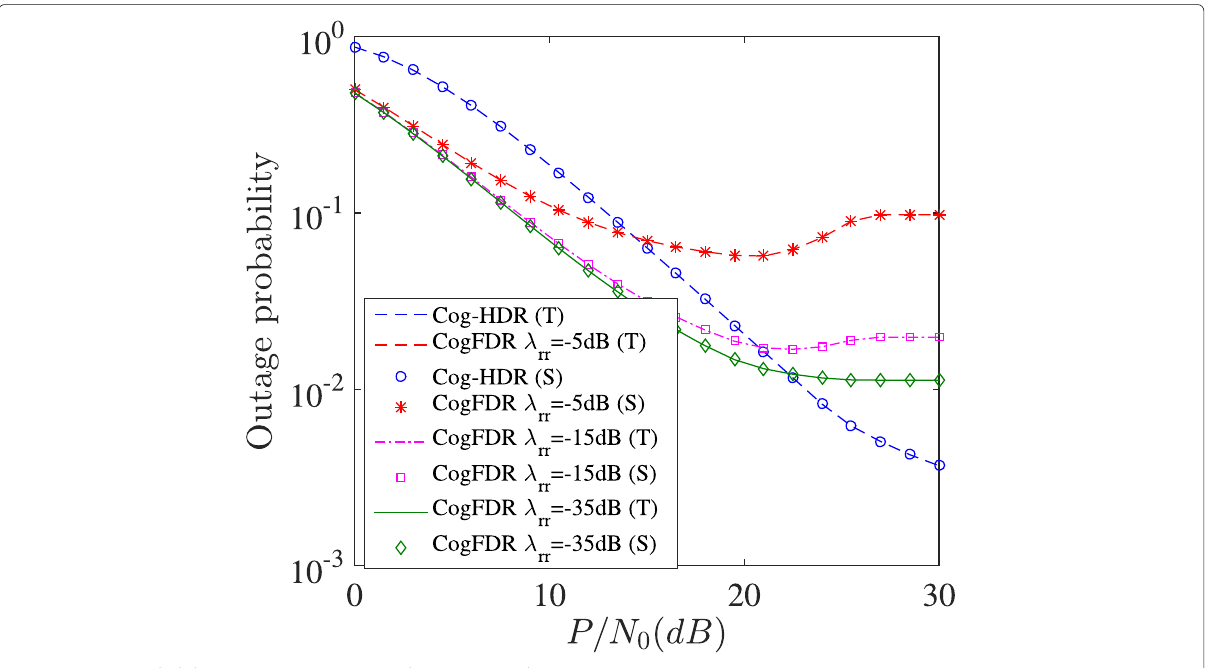
Fig. 3 Outage probability vs. P / N 0 ; I avg / N 0 = 20 dB ( λ rr = − 40 dB)